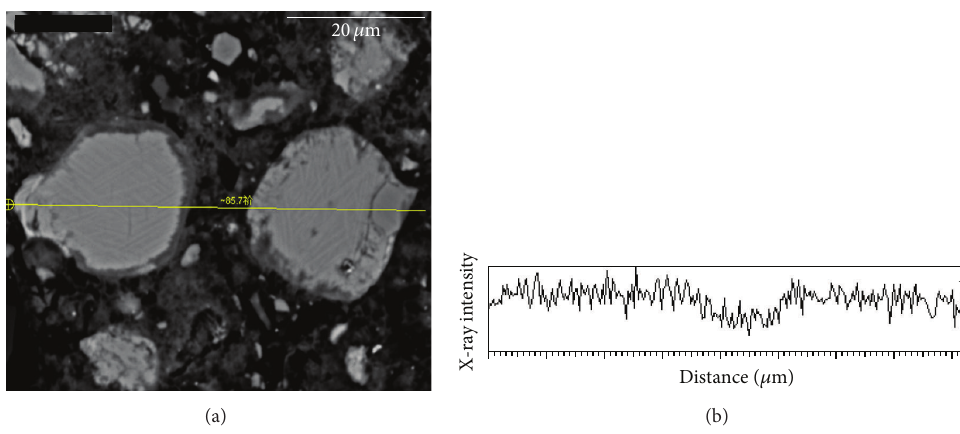
Figure 3: EPMA line analysis of two blocks of C-S-H gels in cement paste and relevant results of As.